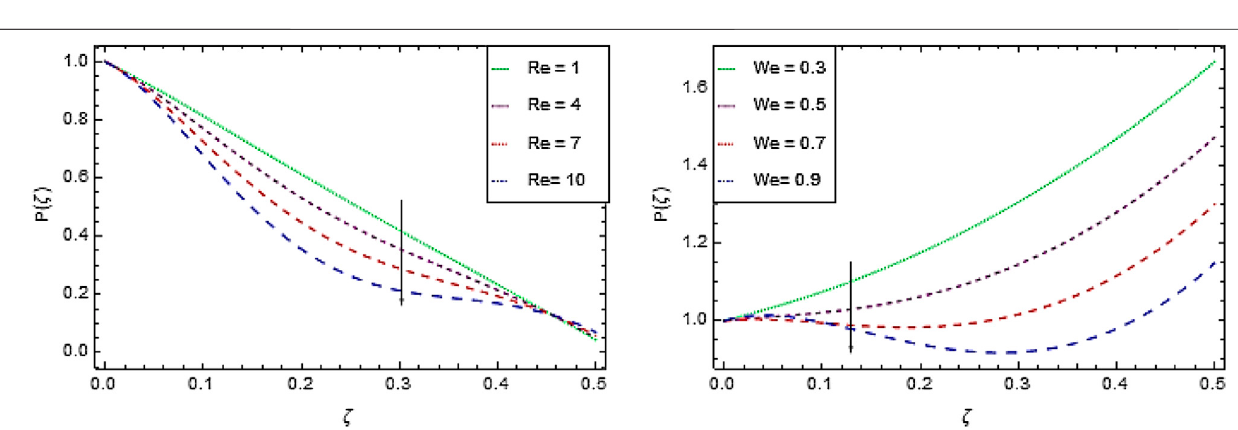
heating amount takes place, and then transferred to the fl uid through the disk surface due to the increase in temperature θ ( ζ ) . Figure 5B shows that when Eckert number Ec increases, the temperature θ ( ζ ) is increased. Ec is the link between the enthalpy fl ow and the kinetic energy. Work vs. viscous liquid stress is used to convert kinetic